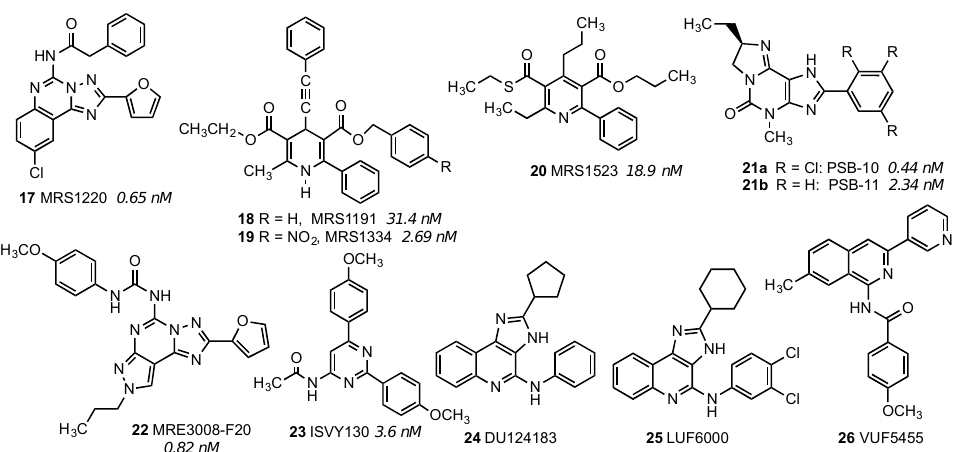
Figure 2. Selected representative nonnucleoside A 3 AR antagonists 17 – 23 and allosteric enhancers 24 – 26 . Antagonist Ki values in the hA 3 AR are shown [1,6,29–31].